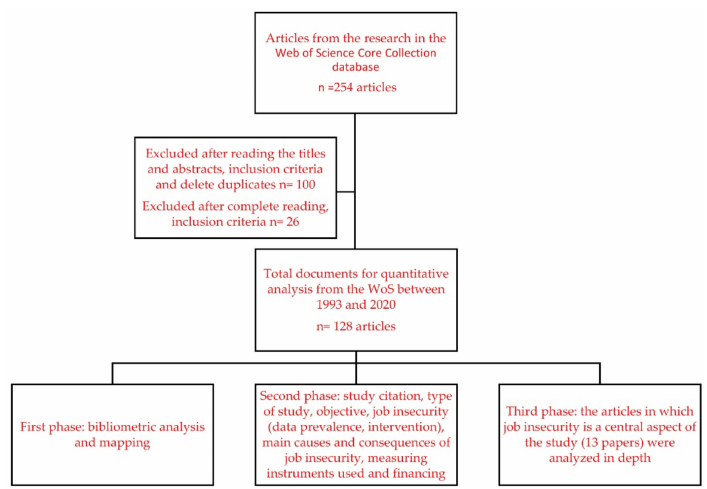
Figure 1. Selection of articles and research design